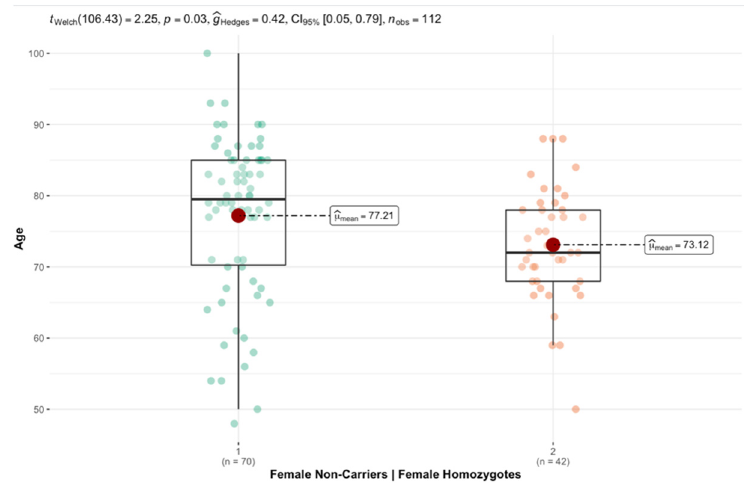
Figure 2. Average age x, female APOE4 non-carriers vs. female APOE4 homozygotes. Graphical depiction of the average age of female APOE4 non-carriers and female APOE4 homozygotes, illustrating the significant difference between the two groups. On average, female APOE4 homozygotes were significantly younger than female APOE4 non-carriers (g = 0.42, 95%CI [0.05, 0.79], p = 0.03).